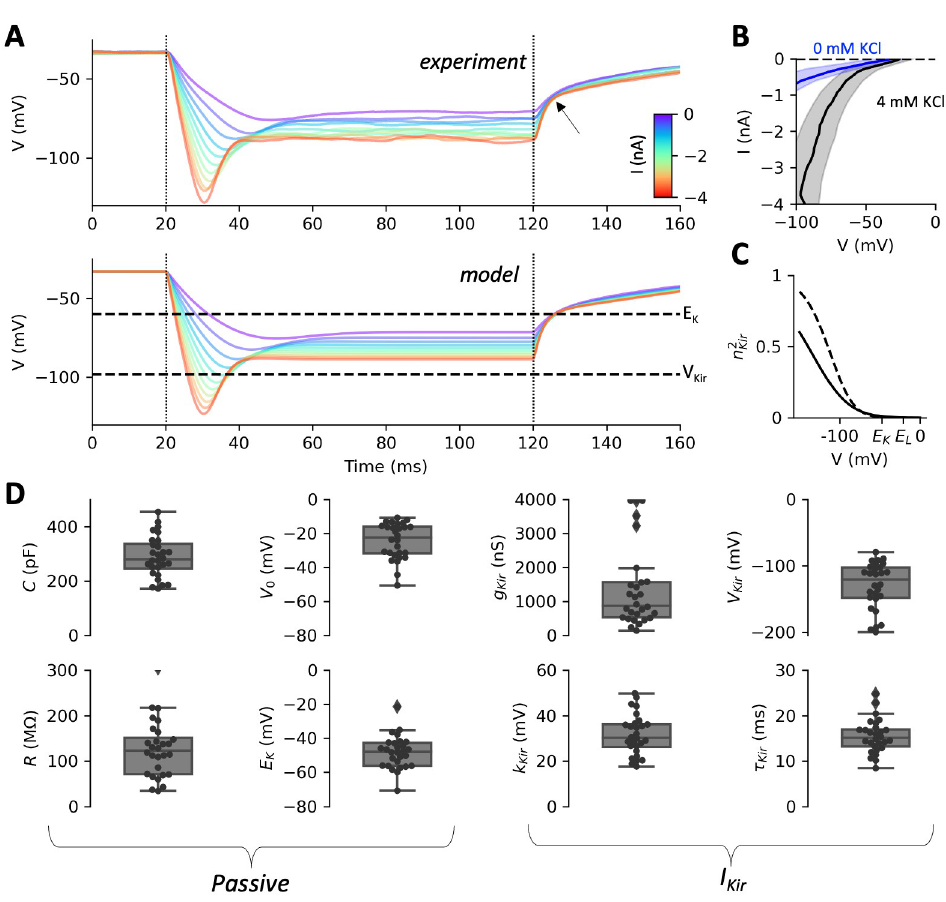
Fig 5. Passive properties and inward rectifier current. A, Top: voltage responses of one cell to negative current pulses (I = 0 to -4 nA in 300 pA increments; dashed lines: start and end of pulses), in the standard extracellular solution (4 mM KCl and 1 mM CaCl 2 ). The arrow points at an inflexion due to the inward rectifier current I Kir . Bottom: model responses fitted to the data, showing the inferred reversal potential of K + (E K ) and the half-activation voltage V Kir of the inward rectifier current. B, Current-voltage relationship over all cells (mean ± standard deviation, measured at pulse end) in 4 mM KCl (grey) and 0 mM KCl (blue). Removing K + from the extracellular solution largely suppresses the inward current. C, Activation curve of the inward rectifier current in the fitted models. The current activates below E K (E L is leak reversal potential). The solid curve is the activation function with median parameters, the dashed curve is the activation function of the cell shown in A. D, Fitted parameters over n = 28 cells, grouped in passive parameters and inward rectifier